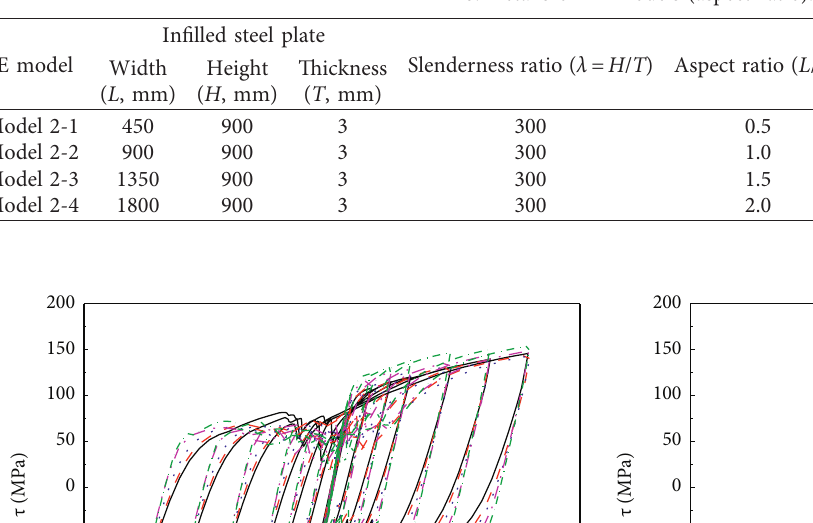
Table 10: Details of FE models (aspect ratio).